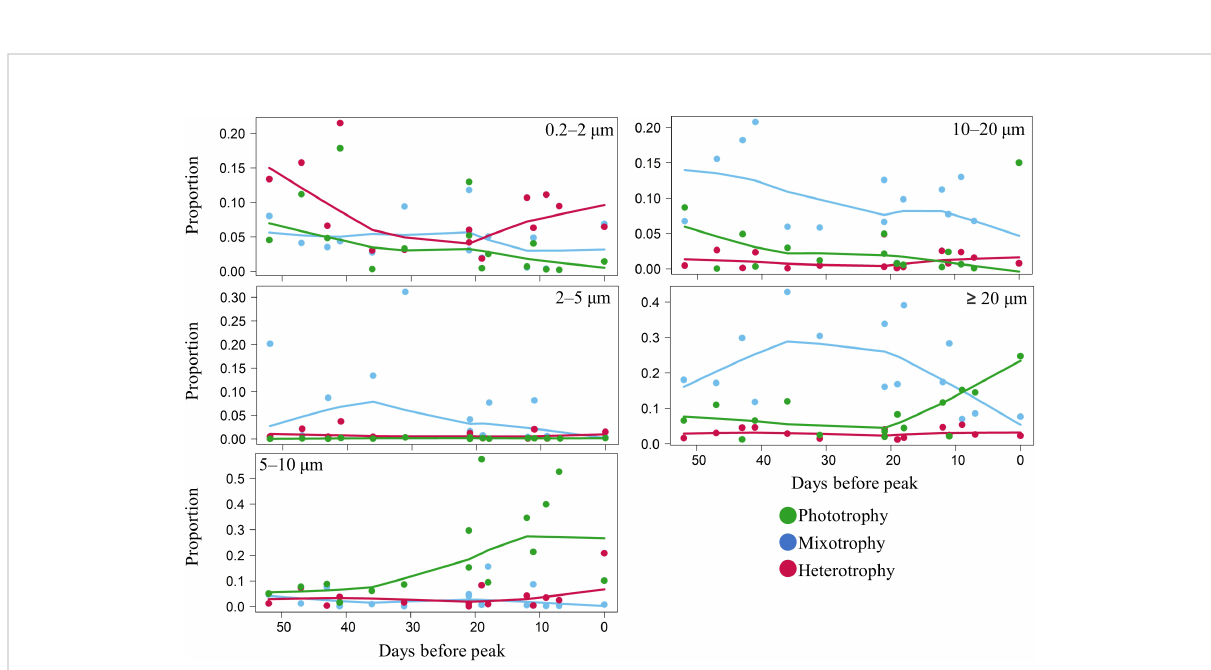
FIGURE 4 The smoothed (LOWESS function, stats core R package, 60% span) relationship between the proportion of each trophic strategy by size